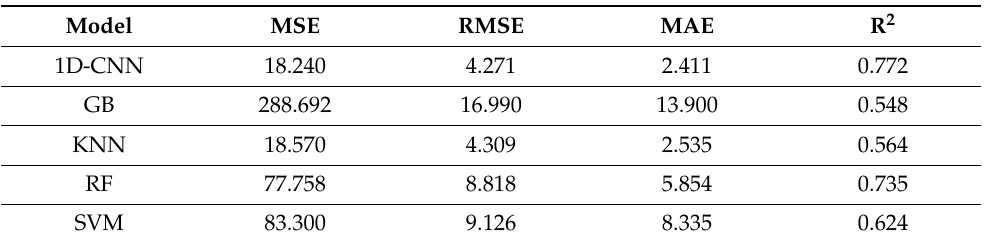
Table 15. Comparative model validation result of the slurry test with SAND_PROD_PER_AREA as the output.